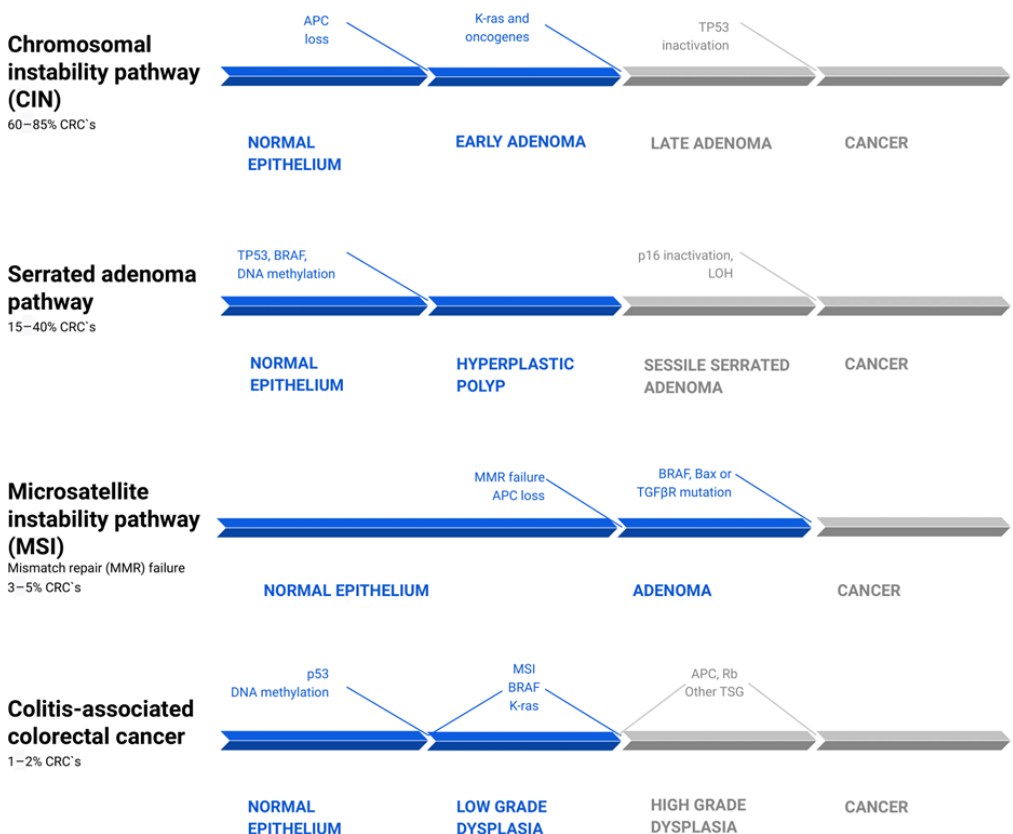
Figure 1. Common pathways of colorectal cancer pathogenesis [10,23,25–27]. There are four parallel pathways involved in CRC progression. The chromosomal instability pathway (CIN) accounts for 60–85% of CRC. Mutations, such as APC loss, activation of K-ras or other oncogenes, and then Tp53 inactivation, drive clonal cell growth and ultimately the formation of invasive cancer. The serrated adenoma pathway is responsible for 15–40% of CRC. The occurrence of a BRAF mutation and methylation of cell cycle controlling leads to uncontrolled proliferation of tumor cells. Subsequent methylation of other genes, such as tp53 and p16, promotes the evolution of CRC. Microsatellite instability pathway (MSI) failure leads to 3–5% of CRCs and is driven by simultaneous loss of APC and DNA mismatch repair genes (MMR) failure. The following BRAF, Bax, or TGF β R mutation pushes the tumors from adenoma to CRC. Colitis-associated colorectal cancer accounts for about 1–2% of all CRCs. Its mechanism is similar to that in the pathogenesis of sporadic cancer, including p53, DNA methylation, MSI, BRAF, and K-ras mutations. However, they differ in timing and frequency of specific alterations. These mutations lead to low-grade dysplasia, which, after mutations of APC, Rb, and other TSG, progress to high-grade dysplasia and subsequently to cancer. CRC—colorectal carcinoma; LOH—loss of heterozygosity; TSG—tumor suppressor